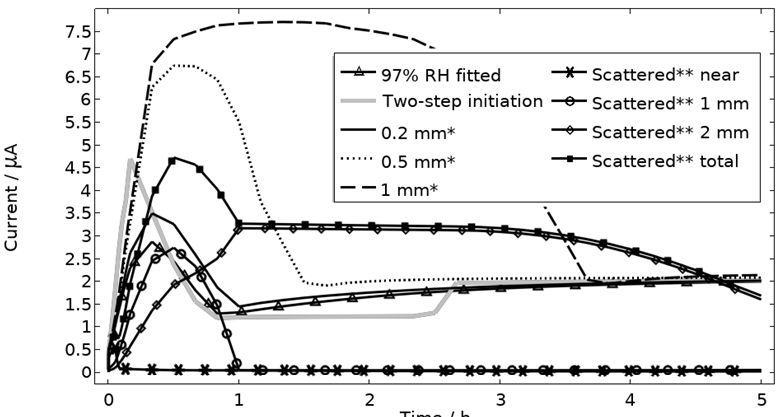
Figure 15. Galvanic currents with varied descriptions of the corroding surface for exposure with 86 μg NaCl/cm 2 load at 21 °C and 97% RH. Two-step initiation sets half of the corroding surface active for the first 2.5 h of the exposure and the full area for the latter 2.5 h. * The whole corroding surface is located 0.2 mm, 0.5 mm, or 1 mm from the inert region. ** The corroding surface area is the same size as the fitted case (Figure 9) but scattered in three separate areas with 70% of it being located near, 20% 1 mm away from, and 10% 2 mm away from the inert region. Data given for each separate area and for the whole area.